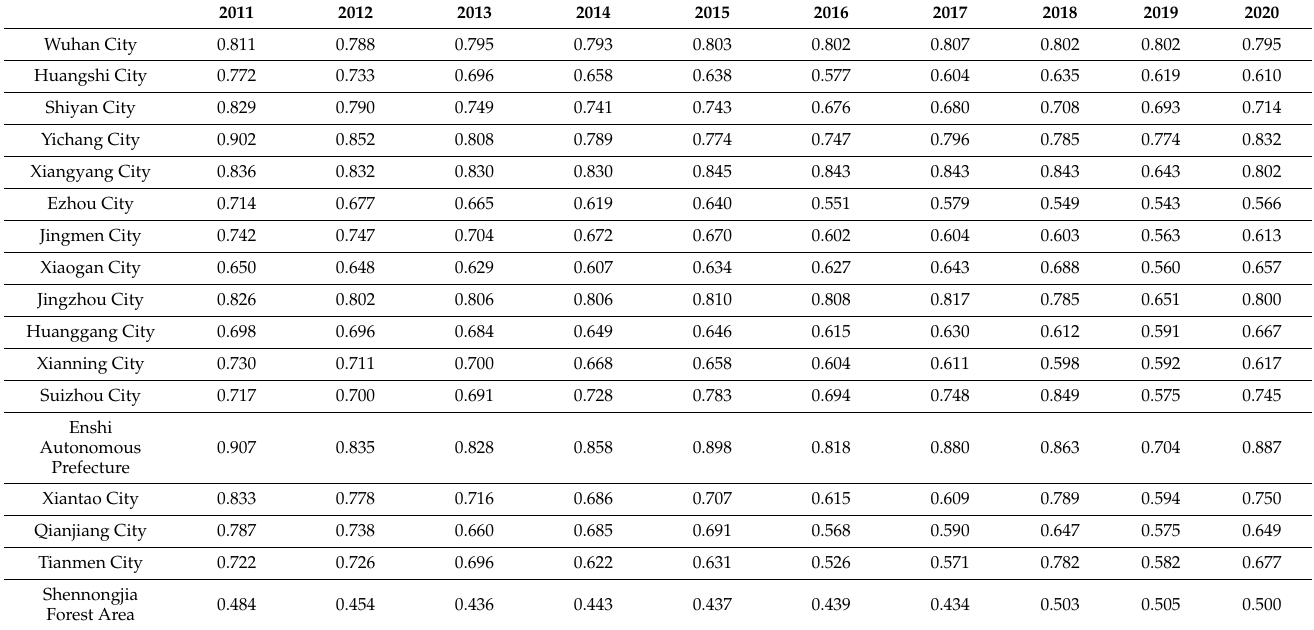
Table 3. Comprehensive asset coefficient of prefecture-level cities in Hubei Province from 2011 to